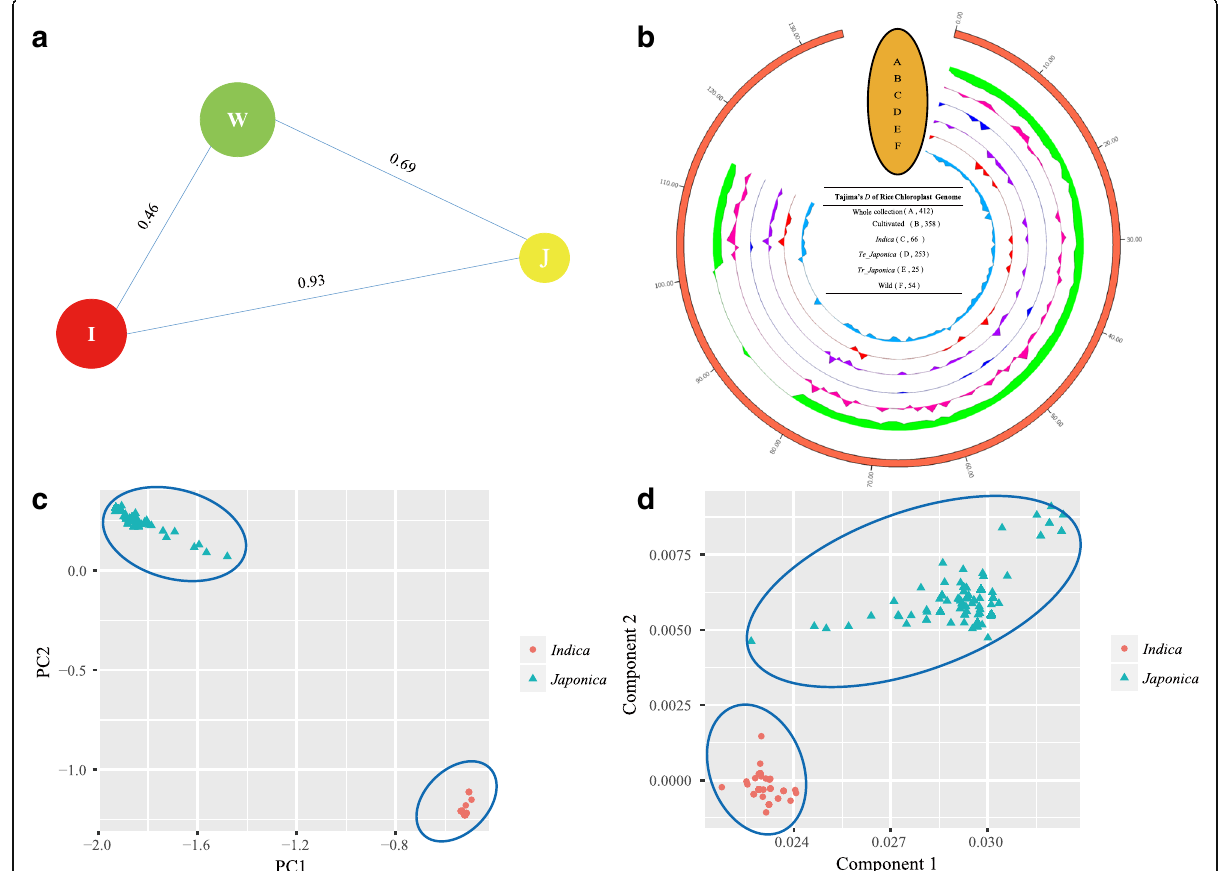
Fig. 6 F ST , Tajima ’ s D test, principal component analysis and multidimensional scaling of populations. ( a ) The F ST value between Asian rice and wild rice, the circle size displayed the diversity of each group. The F ST value between each group was marked by the length of each line. R: O. rufipogon , J: temperate japonica and temperate japonica . ( b ) Tajima ’ s D values in subgroups. ( c ) Principle component analysis of indica and japonica. ( d ) Multidimensional scaling plots of indica and